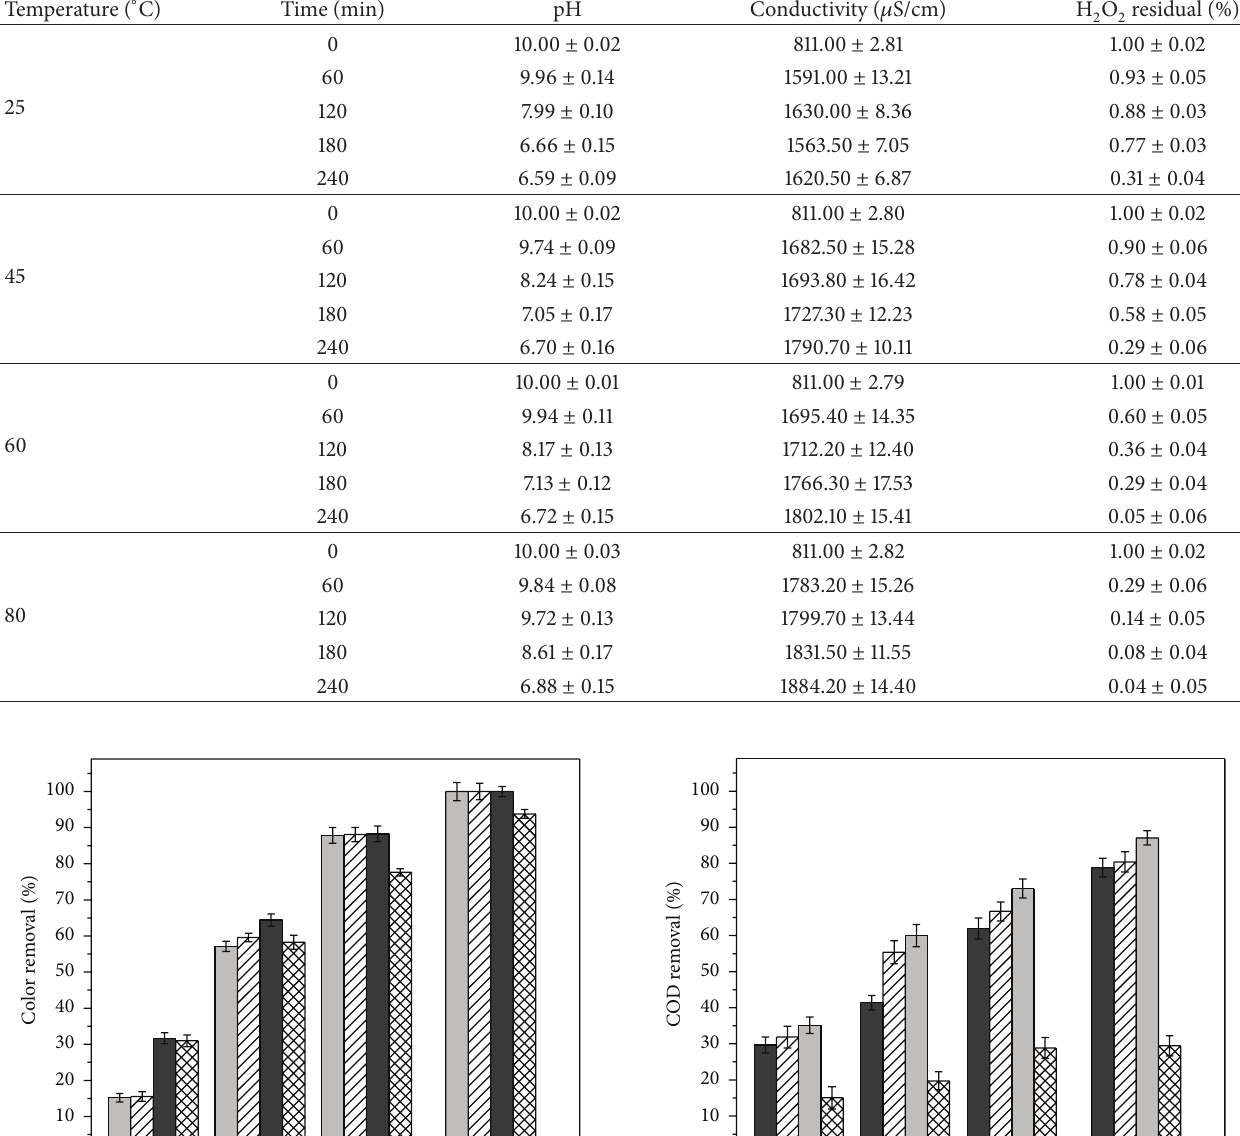
Table 3: Effect of the irradiation time and temperature in some physical-chemical parameters. Experimental conditions: UV/1% H initial pH of 10.